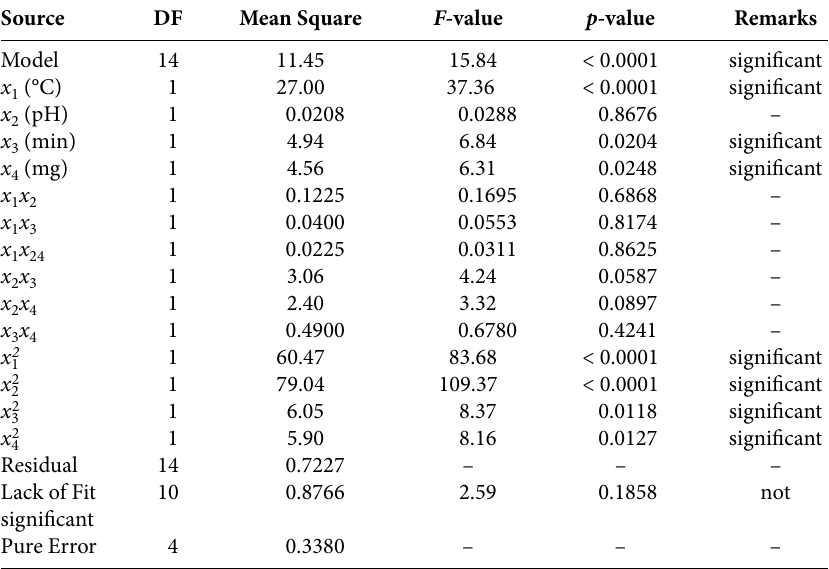
Table 4. Analysis of variance for the model by BBM optimization for As(v) adsorption